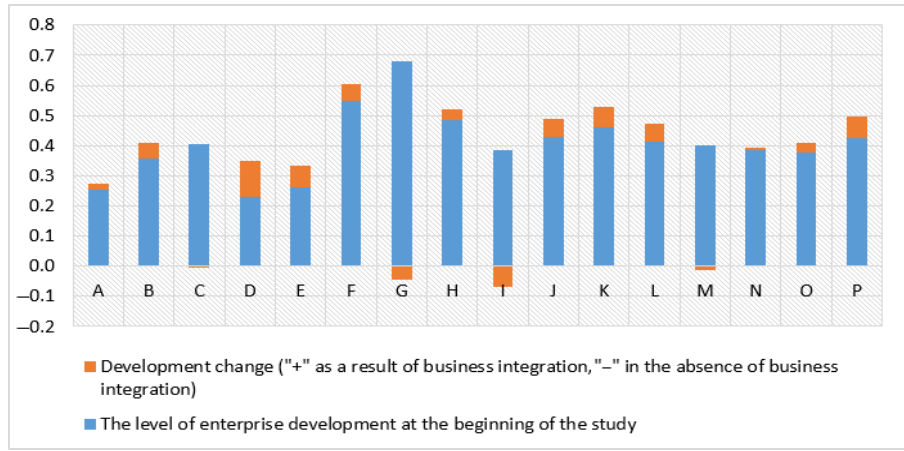
Figure 5. Modeled development indicators of the studied enterprises as a result of integration using a replication model. Source: Formed by the authors.